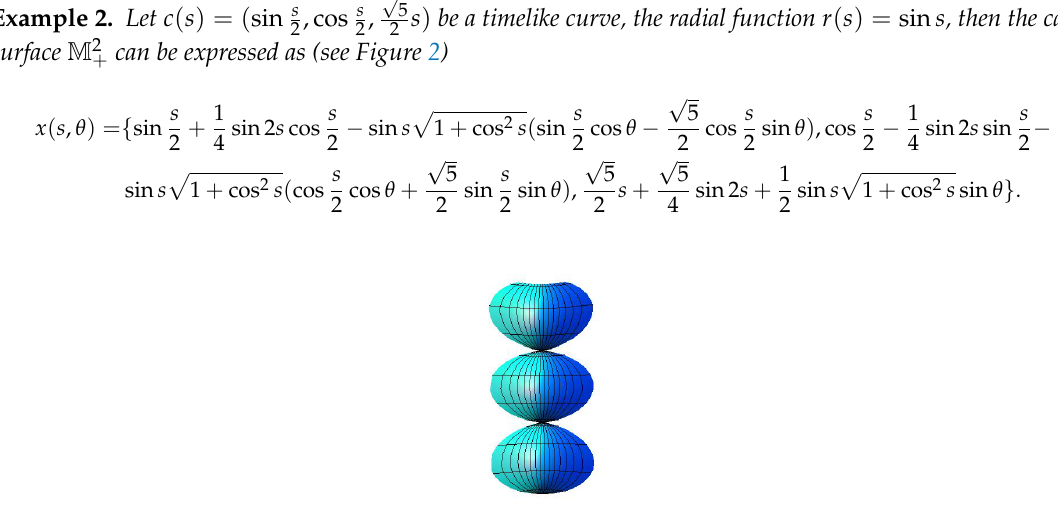
Figure 1. M 11 + ( M 12 + ) with r ( s ) = sin s